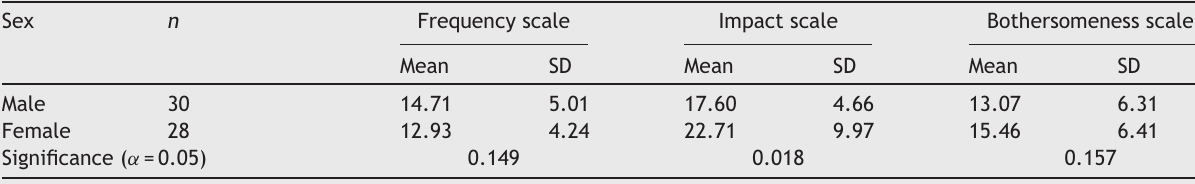
Significance ( ˛ = 0.05)